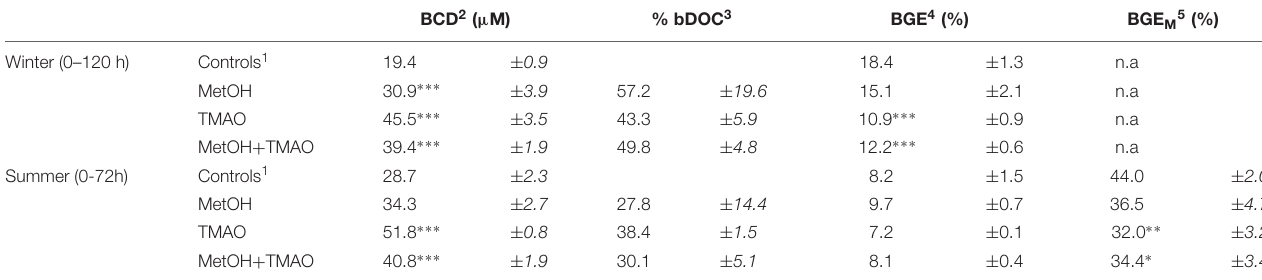
TABLE 2 | Summary of data during the active phases of the enrichment experiments, 0–120 h and 0–72 h of incubation in winter and summer, respectively (mean ± standard deviation for n = 3 for enrichments and n = 6 for